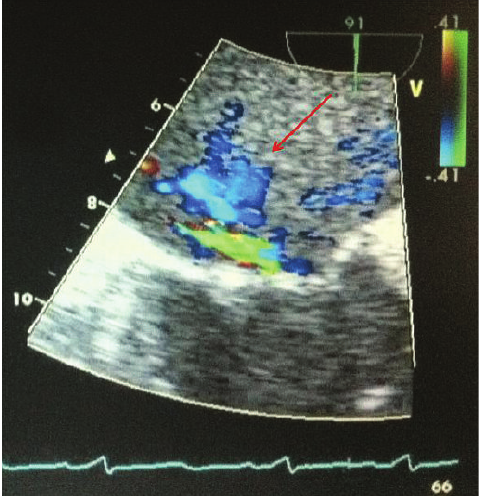
Figure 2: TEE showing scallop prolapse of the anterior mitral leaflet and severe mitral regurgitation (red